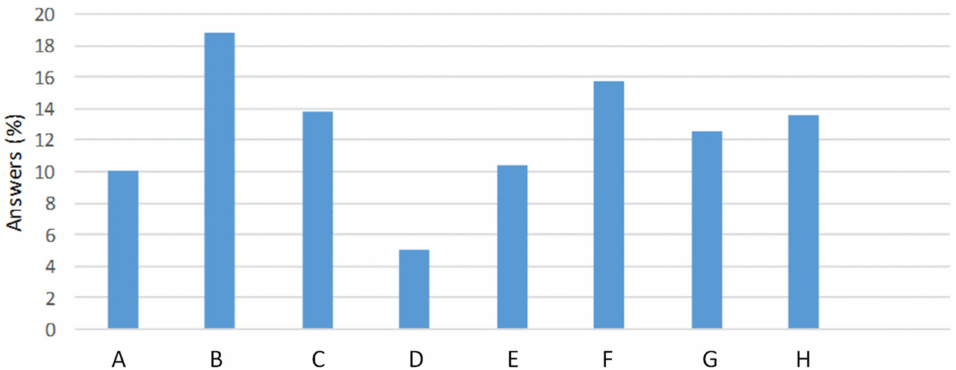
Figure 1. Percentages of the answers (1576) given by farmers/producers, consumers, analysts and regulatory bodies to the eight following questions: ( A ) detection of pesticides and other contaminants; ( B ) geographical identification (identification of production areas); ( C ) detection of critical points affecting to quality; ( D ) reproducibility in the production between crops and extraction systems; ( E ) detection of critical points affecting safety; ( F ) detection of adulteration of olive oil; ( G ) prediction of protection designation of origin (PDO); and ( H ) additional guarantee of the product to gain consumer confidence (competitive product